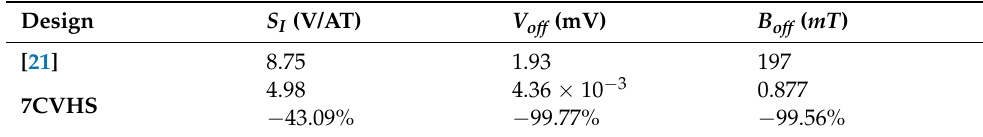
Table 3. Performance comparison with the design in